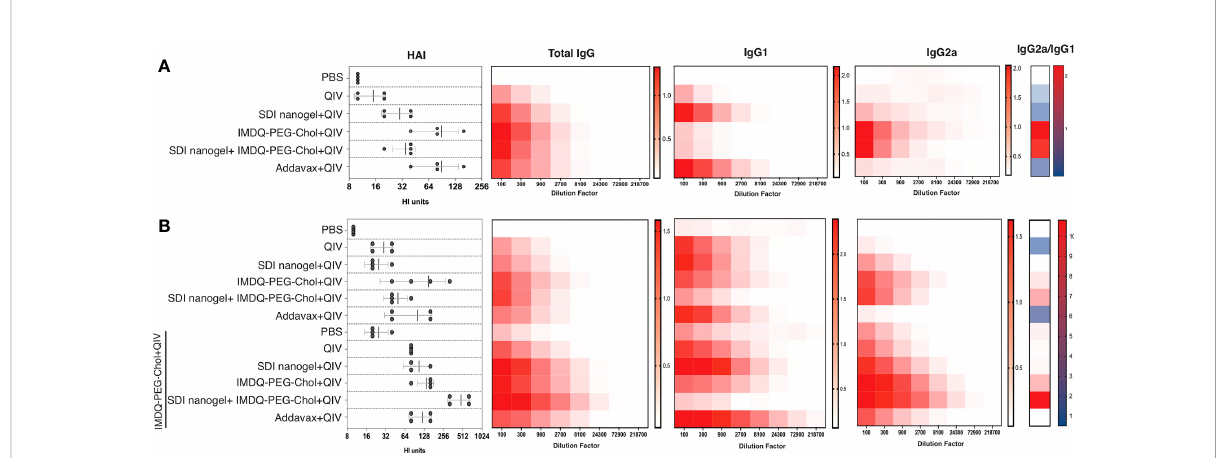
FIGURE 4 SDI+nanogel and IMDQ-PEG-Chol, individual or combined, de fi ne IgG subtype pro fi le: Average OD 450 ELISA values (n=4/group) plotted against serum dilutions, 4 weeks post-prime (A) , 8 weeks post-prime (B) which is 4 weeks post-boost for half of the mice as indicated (B) . HAI was performed using 4 HA units of IVR-180 virus (left top and bottom panels). Total IgG, IgG1 and IgG2a titers were quanti fi ed by ELISA with 3-fold serum dilutions starting with 1:100 and shown as heatmaps. The ratio of IgG2a/IgG1 was calculated based on the mean of area under the curve for individual animals in all groups. The HAI titers are represented as geometric mean ± geometric